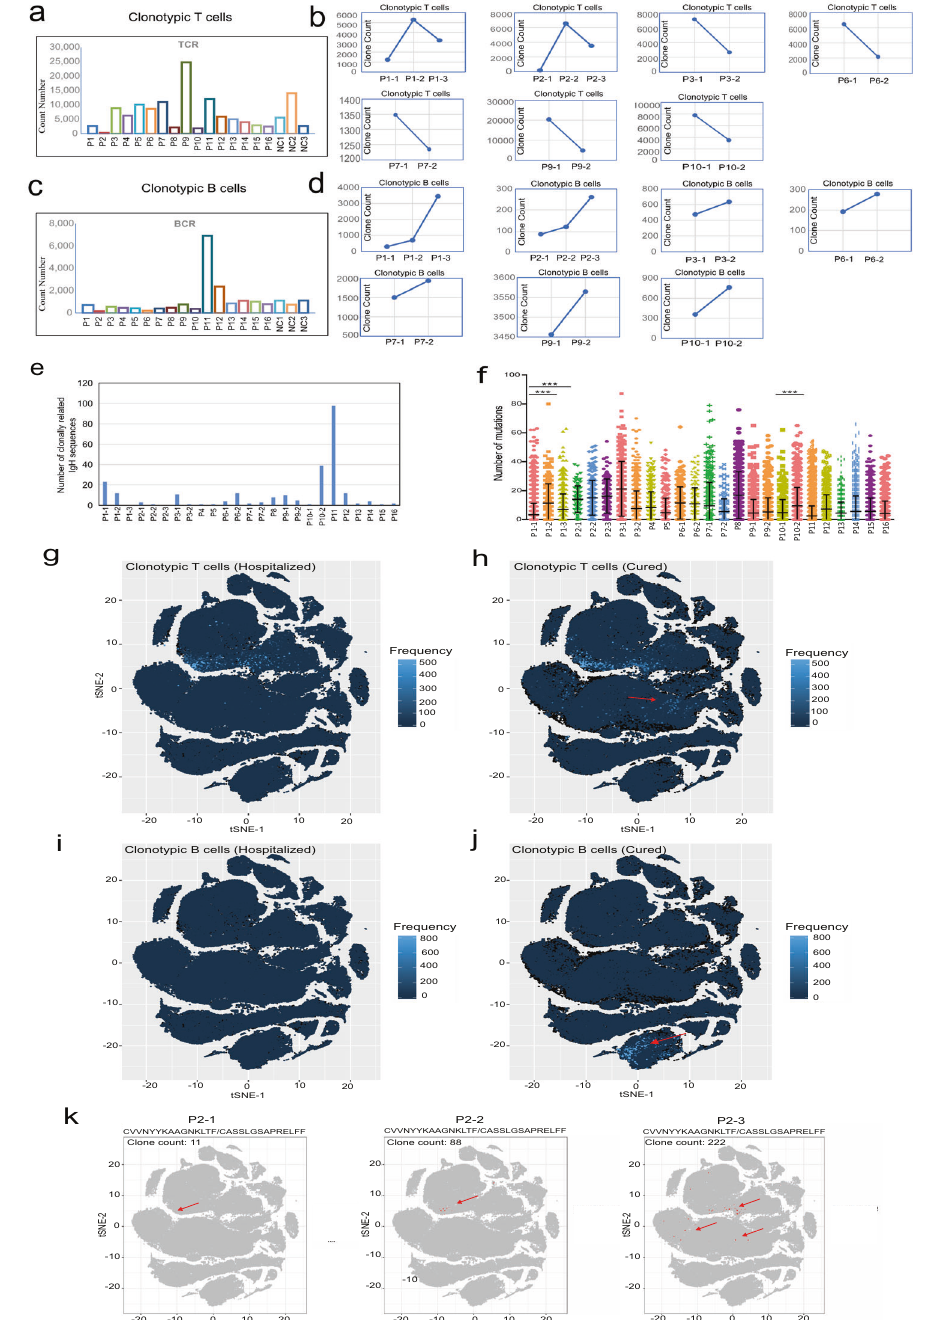
Fig. 5 T lymphocytes and B lymphocytes V(D)J clone expansion and TSNE plots of integrated analysis of 5 ′ mRNA, T cell receptor (TCR), and B cell receptors (BCR) of patients with COVID-19. a The number of T cell clones detected by V(D)J in each patient. b The number of T cell clones detected by disease condition and the recovery condition of patients 1, 2, 3, 6, 7, 9, and 10. c The number of B cell clones detected by V(D)J in each patient. d The number of B cell clones detected at disease and recovery conditions of patients 1, 2, 3, 6, 7, 9, and 10. e Clonally related IgH sequences in each patient. f Number of mutations in IgH gene variable regions in different COVID-19 patients. The statistical signi fi cance refers to the statistics of different courses of the same patient who had dynamic analysis data. * P < 0.05, ** P < 0.01, *** P < 0.001; t- test. g Clonotypic T cells of hospitalized patients. h Clonotypic T cells of cured patients. i Clonotypic B cells of hospitalized patients. j Clonotypic B cells of cured patients. Patients in hospitalized condition: P1-1, P1-2, P2-1, P2-2, P3-1, P6-1, P7-1, P9-1, and P10-1. Patients in cured condition: P1-3, P2-3, P3-2, P6-2, P7-2, P9-2, and P10-2. The detailed cell types of these patients are shown in Fig. 3a. k TSNE plot of a clonotypic T cell (terminal effector CD8 T cells): CVVNYYKAAGNKLTF_CASSLGSAPRELFF (TRAV12-1*01, TRAJ17*01, and TRAC*010 in P2-1, P2-2, and